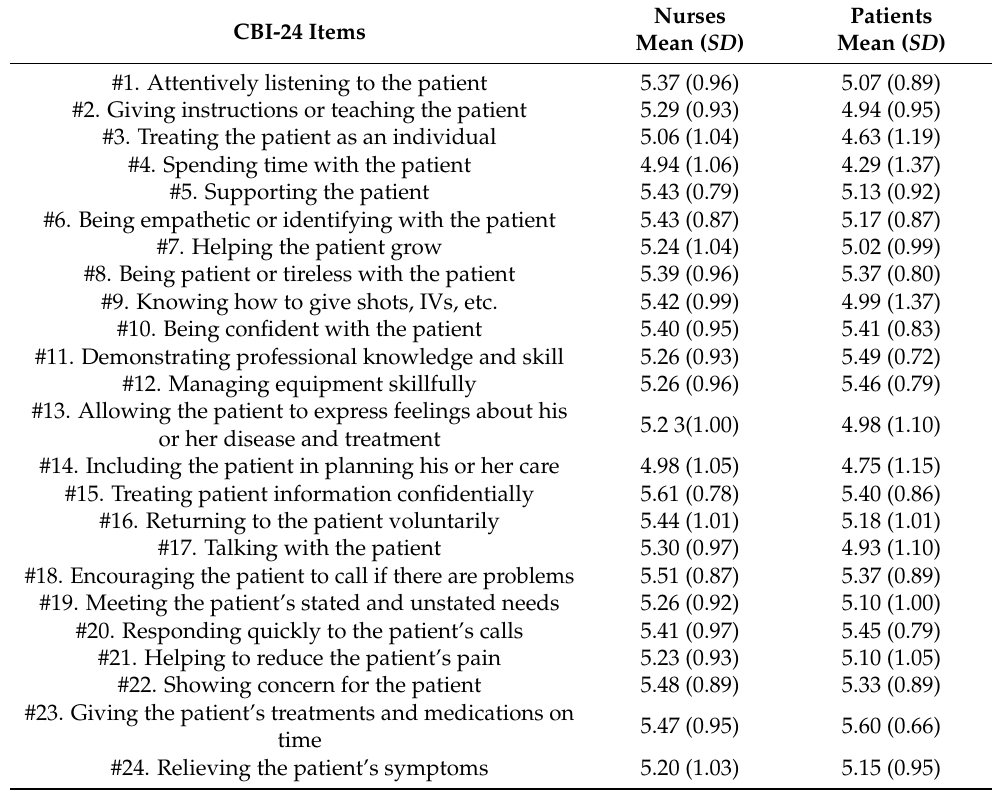
Table 4. Nurse and patient self-evaluated CBI-24 items.